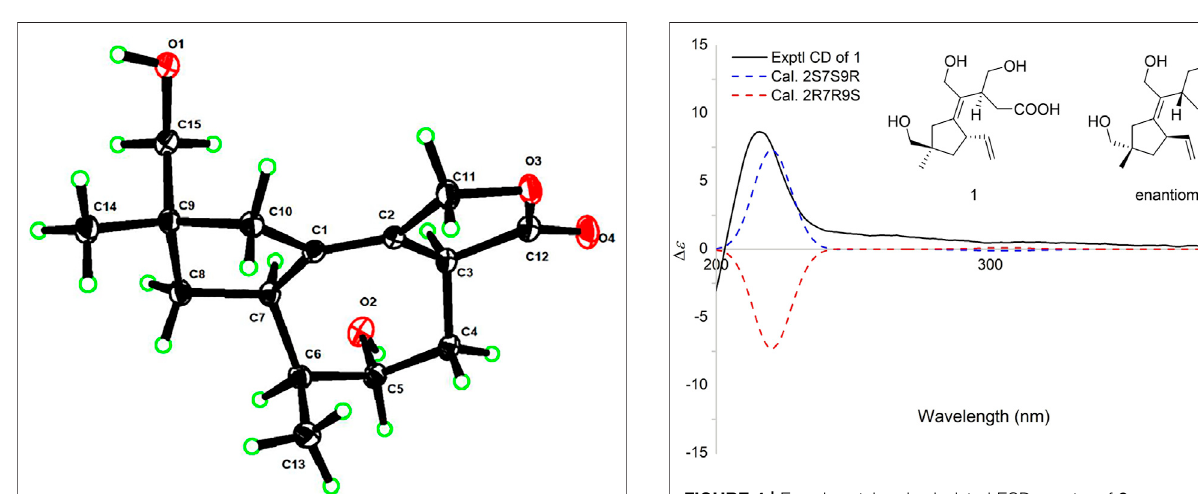
FIGURE 4 | Experimental and calculated ECD spectra of 2